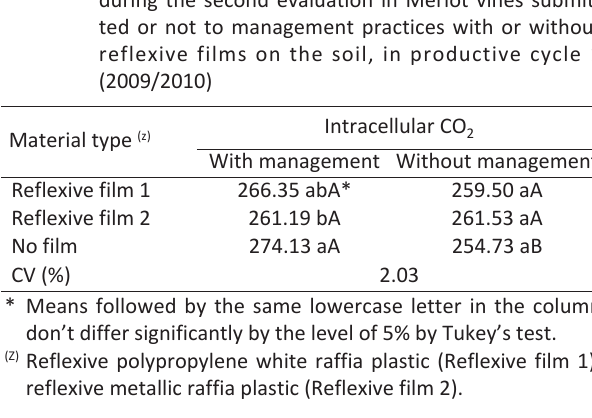
Table 6 - SS/ATT ratio in Merlot vines submitted or not to mana- gement practices with or without reflexive films on the soil, in productive cycle 2 (2010/2011)